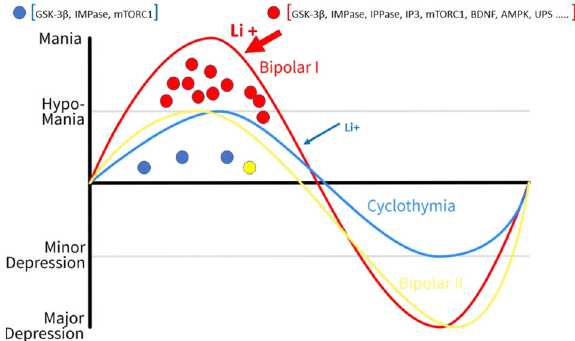
Fig. 3 Neural molecular substrates of lithium determining its differential af fi nity and ef fi cacy for BD1 vs BD2. Circles represent neural molecular substrates of Li + . Red circles represent the most abundant neural targets of Li + underlying its therapeutic ef fi cacy in mania (BD1); blue and yellow circles indicate a progressively decreasing number of neural molecular substrates of Li + in minor and major depressive disorders (cyclothymia and